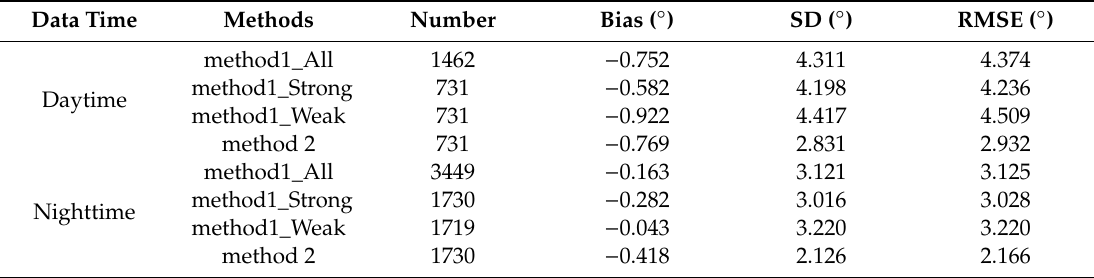
Table 3. The statistical slope errors of our methods using di ff erent ICESat-2